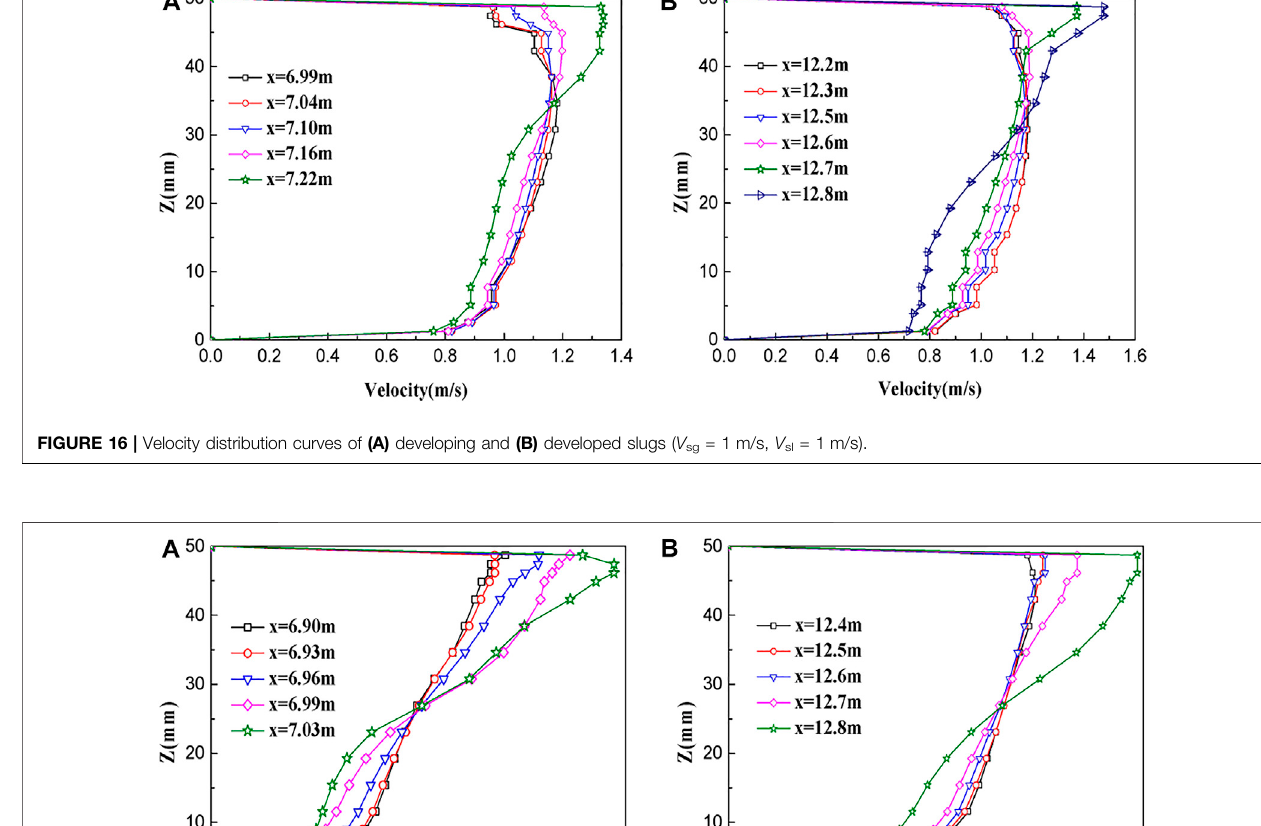
Frontiers in Energy Research |